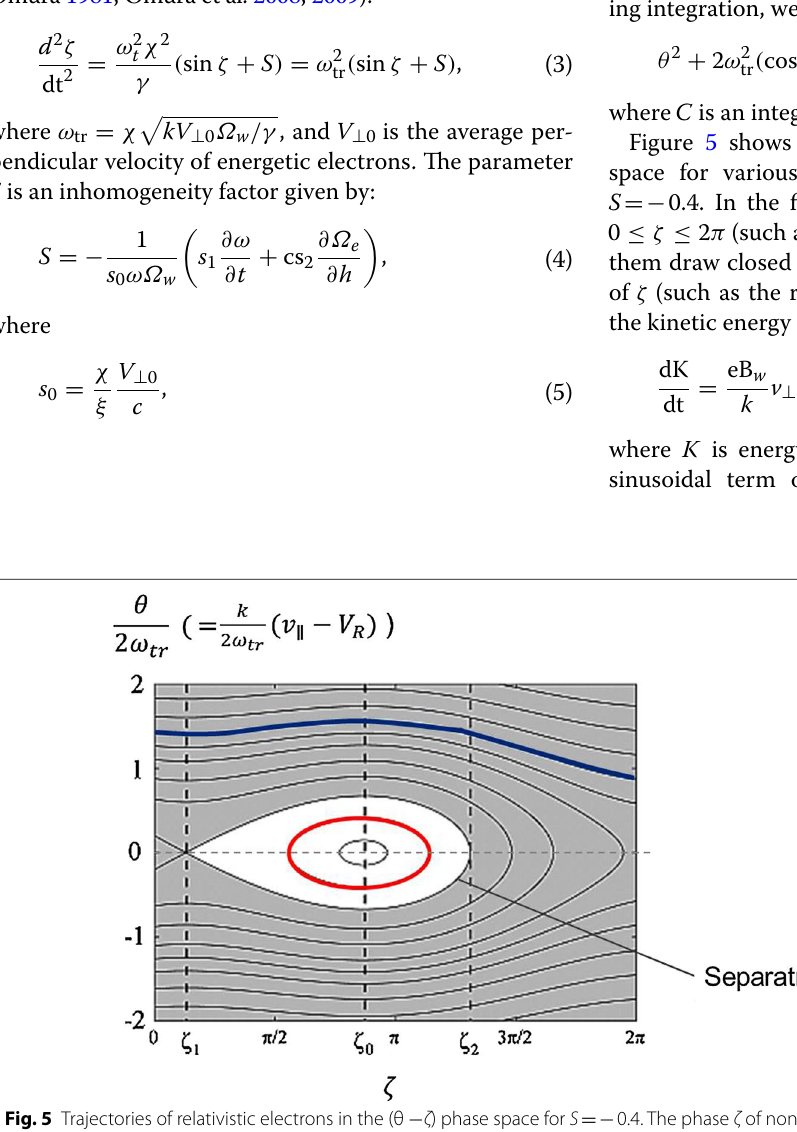
Fig. 5 Trajectories of relativistic electrons in the (θ π (blue line), whereas the oscillation for resonant electrons ( v draw closed phase trajectories is called trapping region (colored in white), and the boundary of the region is defined as separatrix of the trapping region. Resonant electrons continue to gain energy while they are trapped within the